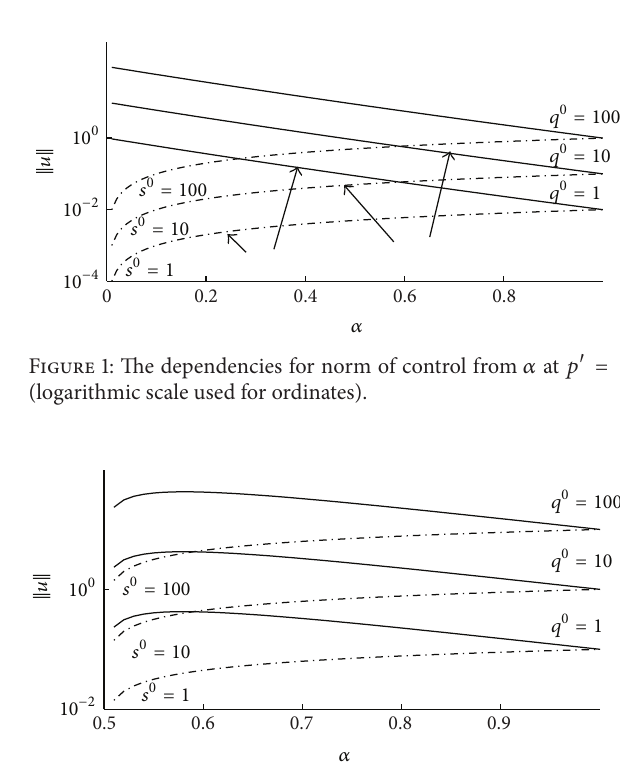
Figure 2: The dependencies for norm of control from 𝛼 at 𝑝 󸀠 = 2 (logarithmic scale used for ordinates).